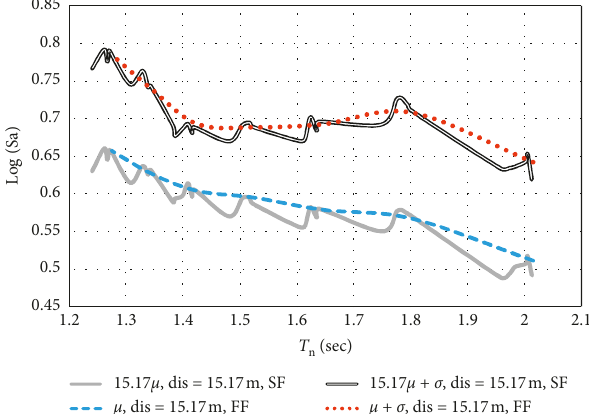
Figure 8: Mean and μ + σ for log of the spectral acceleration for models in the presence (SF) and absence (FF) of a tunnel at a distance of 15.17m from the center of the tunnel projection onto the ground surface.